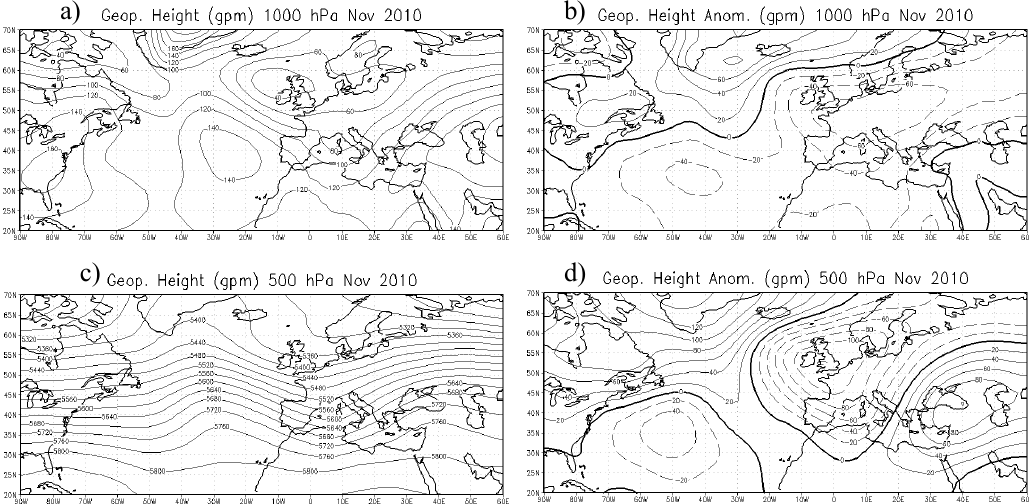
Fig. 4. Mean geopotential fields for November 2010, and mean anomaly field (with respect to the long term 1958–2000 November mean Figure 4 . Mean geopotential fields for November 2010, and mean anomaly field field) at 1000hPa and (with respect to the long term 1958-2000 November mean field) at 1000hPa and